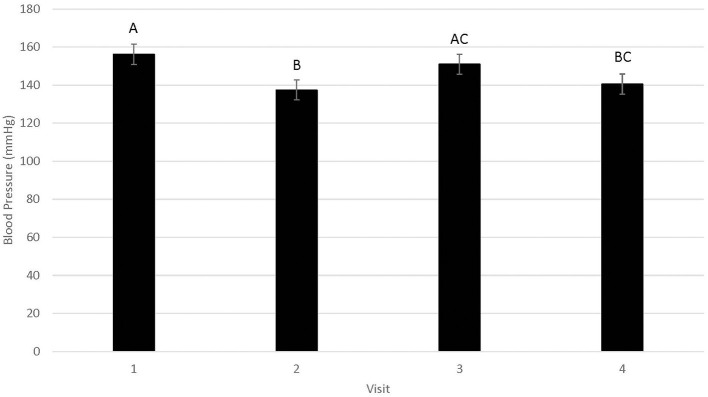
LSMean (±SE) feline blood pressure (mmHg) as assessed using Doppler1 during four visits to a veterinary clinic. Columns letters denote statistical differences between visits (P < 0.05). 1Parks Doppler Flow Detector Model Number 811-B with cuff sizes 2–4 cm was used to measure blood pressure. The tail base the primary site, but the rear leg was used when tails were too short or tail manipulation was not tolerated by the cat. The site chosen for each cat was used across all four visits. Hair was clipped on the first visit to facilitate identification of the pulse prior to placement of the Doppler probe, and was re-clipped as needed during subsequent visits. 2All enrolled cats were mature, healthy, and either spayed or neutered.